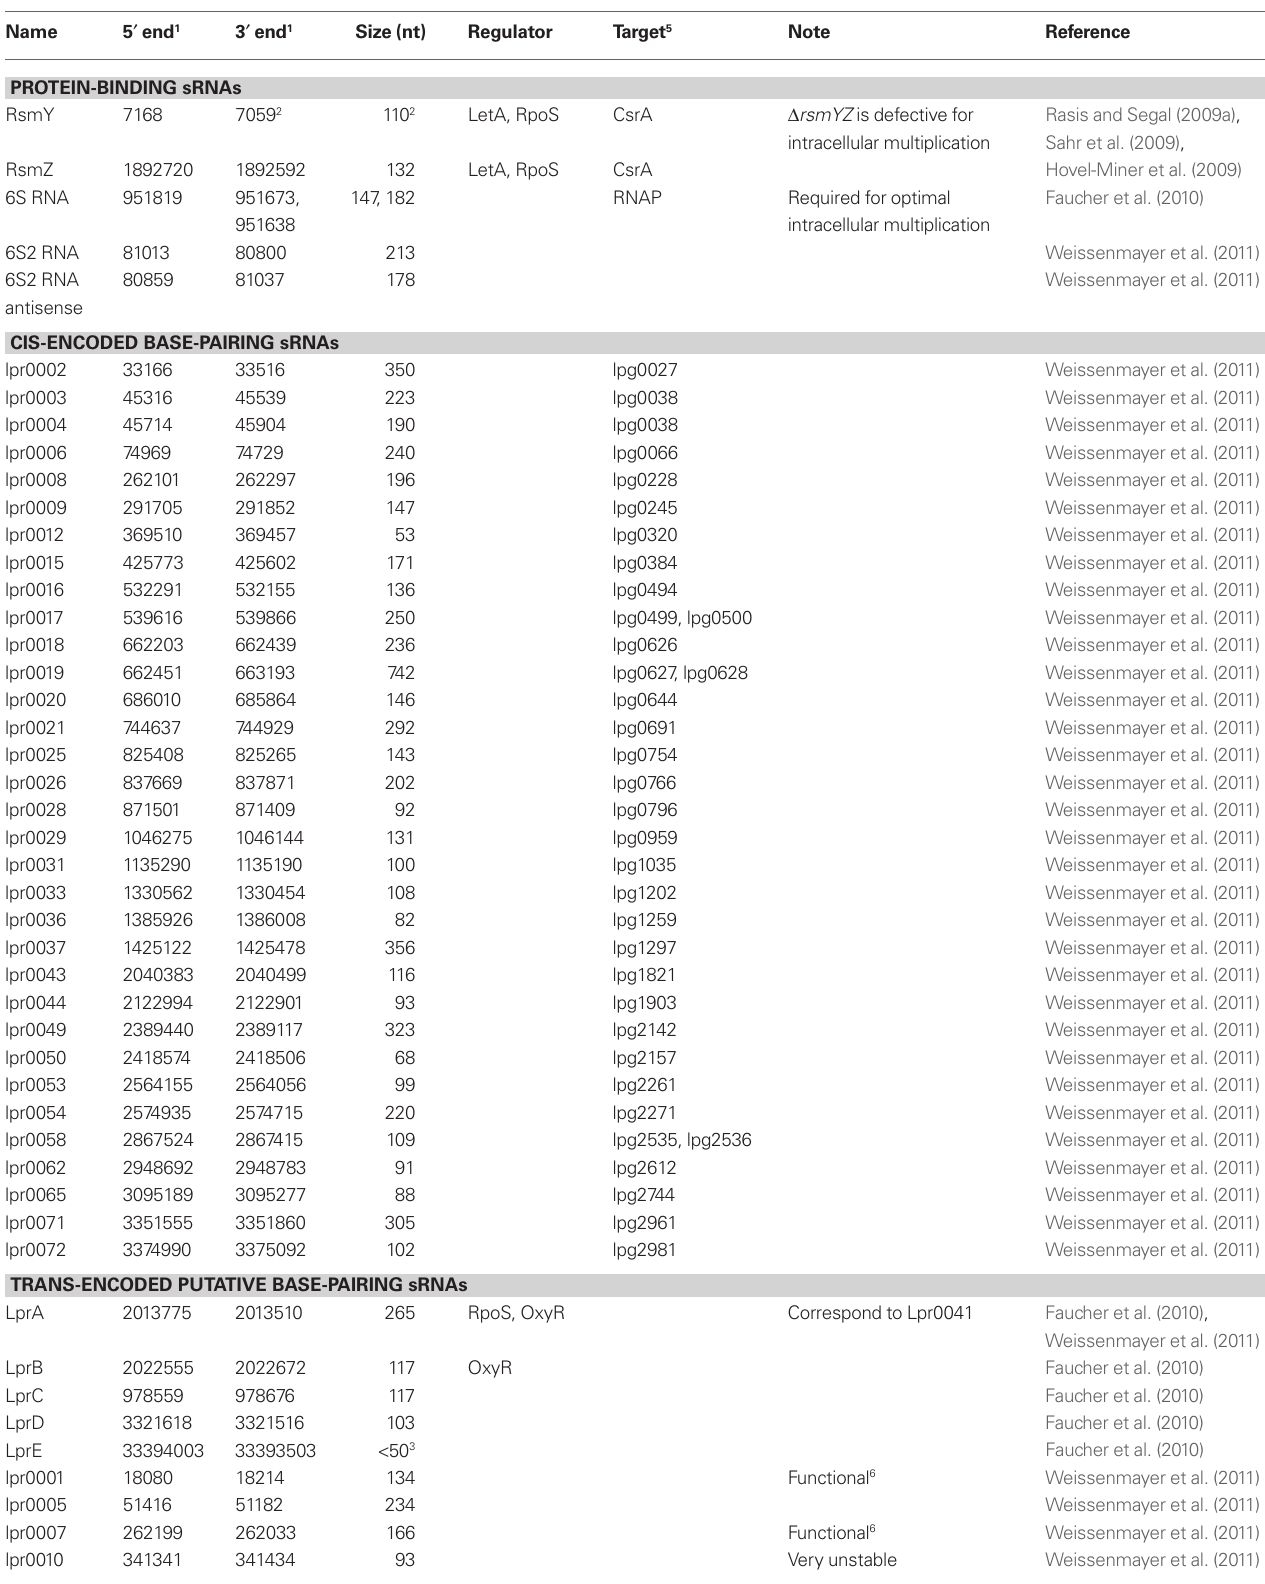
Table 1 | Small RNA molecules identified in L. pneumophila